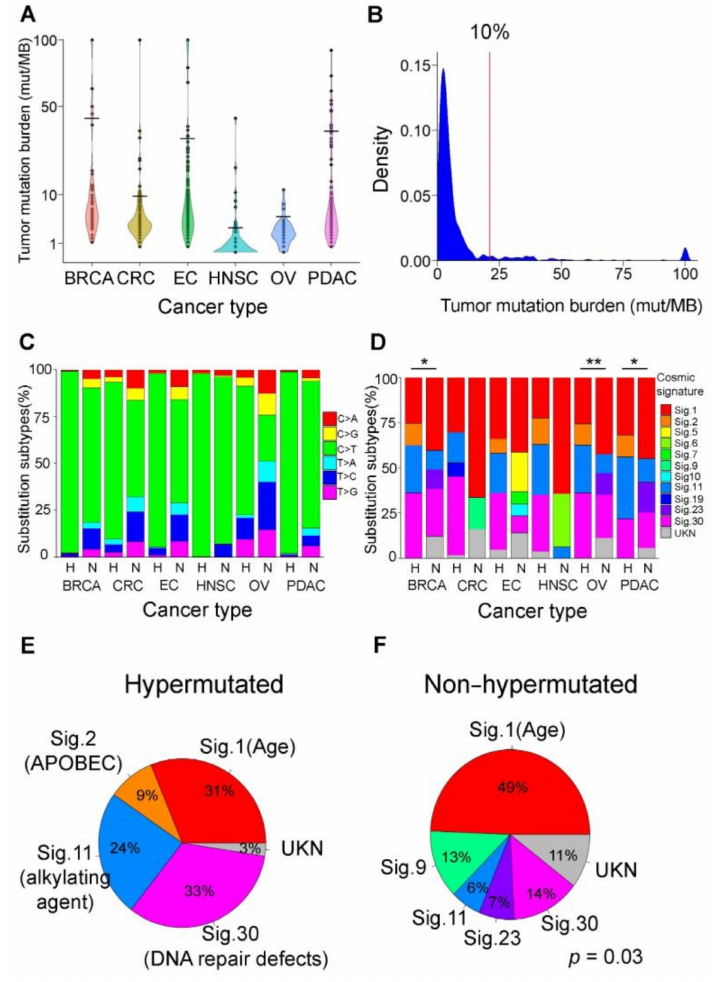
Figure 2. Mutational signatures in hypermutated cancers. ( A ) Violin plot of tumor mutation burden (TMB; number of exonic mutations per megabase) in 533 patients with six different cancer types. The analyzed cohort comprises 55 breast cancer, 129 colorectal cancer, 155 endometrial cancer, 67 oral cancer, 27 ovarian cancer, and 100 pancreatic cancer patients. Patients with TMB values over 100 mutations per megabase (mut/Mb) are labeled 100 mut/Mb. The cutoffs for the highest 10% TMB values in each cancer type are 4.84, 9.53, 35.72, 42.79, 31.83, and 2.87 mut/Mb in ovarian, colorectal, pancreatic, breast, endometrial, and oral cancer, respectively. The TMB data differ for different cancer types. ( B ) Density plot of TMB in all cancer patients. The plot shows the mutation rates across our cohort, and the red line shows the cutoff of the highest 10% TMB values with 21 mut/Mb. ( C ) Frequency of substitution subtypes for six cancer types. Hypermutated (H) and nonhypermutated (N) cancers. Most single-nucleotide mutation substitutions were C > T in cancer tissue. ( D ) Bar plot of the mutational signature in six cancer types for hypermutated. * p -value < 0.05 and ** p -value < 0.01 (H) and nonhypermutated (N) cancers. The percentage of age-related signature 1 in hypermutated cancers is lower than that in nonhypermutated cancers. There were more signatures related to the APOBEC family of cytidine deaminases in hypermutated cancers than in nonhypermutated cancers ( p -value < 0.05). ( E ) Pie chart of mutation signatures for hypermutated cancers. Mutation signatures were constructed, and a higher percentage of signature 11 (alkylating agents) and signature 30 (DNA repair defects) compared to signature 2 ( APOBEC family of cytidine deaminase) is found in hypermutated cancers compared to nonhypermutated cancers ( p -value = 0.03 by chi-square test). ( F ) Pie chart of mutation signatures for nonhypermutated cancers. Mutation signatures were constructed, and a higher percentage of signature 1 (age-related) was found in nonhypermutated cancers than in hypermutated